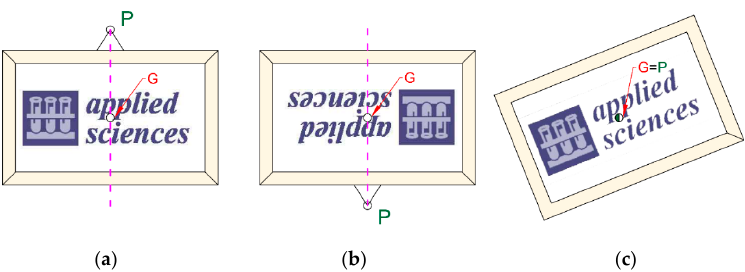
Figure 2. Suspended bodies: ( a ) stable equilibrium, ( b ) unstable equilibrium, and ( c ) indifferent Figure 2. Suspendedbodies: ( a )stableequilibrium, ( b )unstableequilibrium, and( c equilibrium.